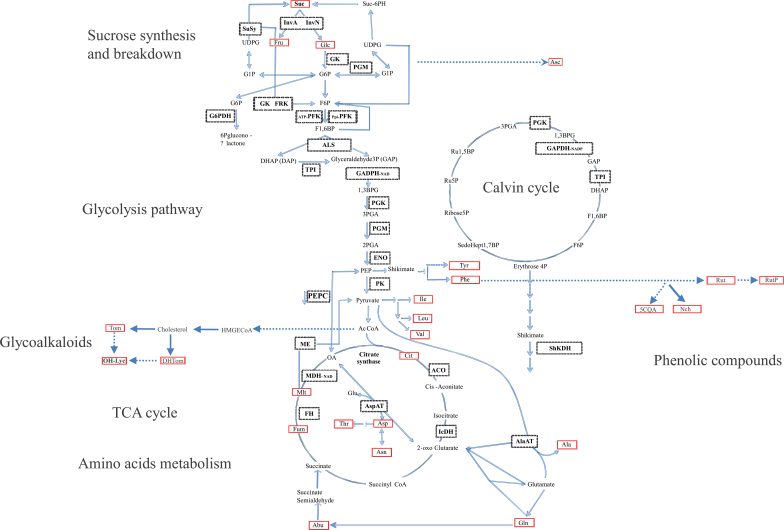
Assignment of the metabolites and enzymes studied to pathways. A total of 26 metabolites are indicated in boxes with solid lines, and 26 enzymes are highlighted in boxes with dotted lines. (This figure is available in colour at JXB online.)